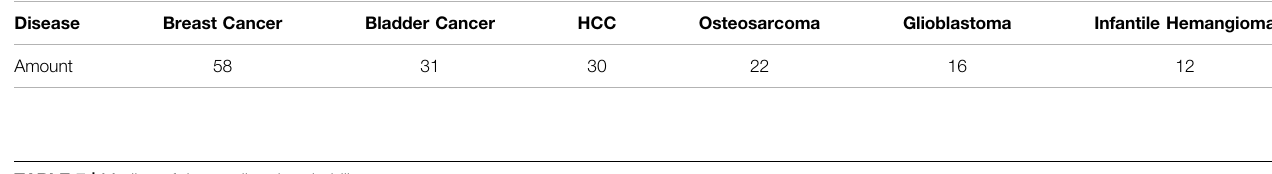
TABLE 7 | Median of the predicted probability. Disease